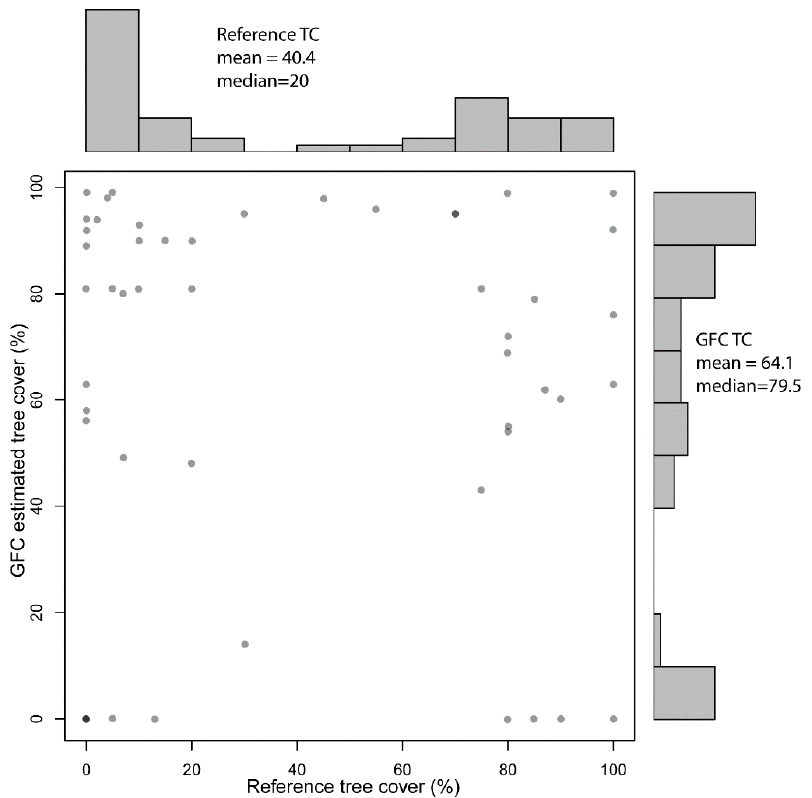
Figure A3. Scatterplot of precipitation and elevation values at reference data locations across Costa Rica. Darker colors indicate higher densities of points, and the blue vertical line indicates precipitation of 2000 mm annually ( ≈ 167 mm on average per month), which is the Holdridge threshold for the low-elevation dry forest biome.